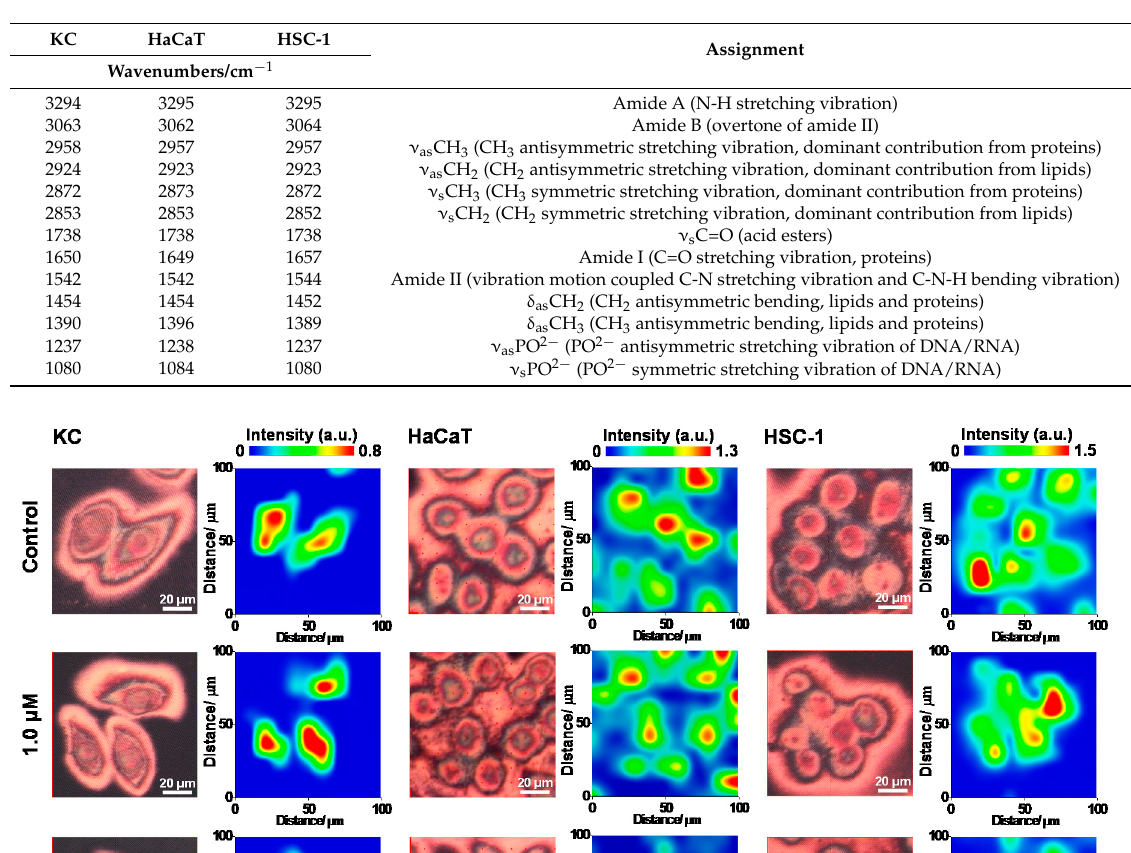
Table 1. Peak assignment of FTIR spectra of skin cell samples.